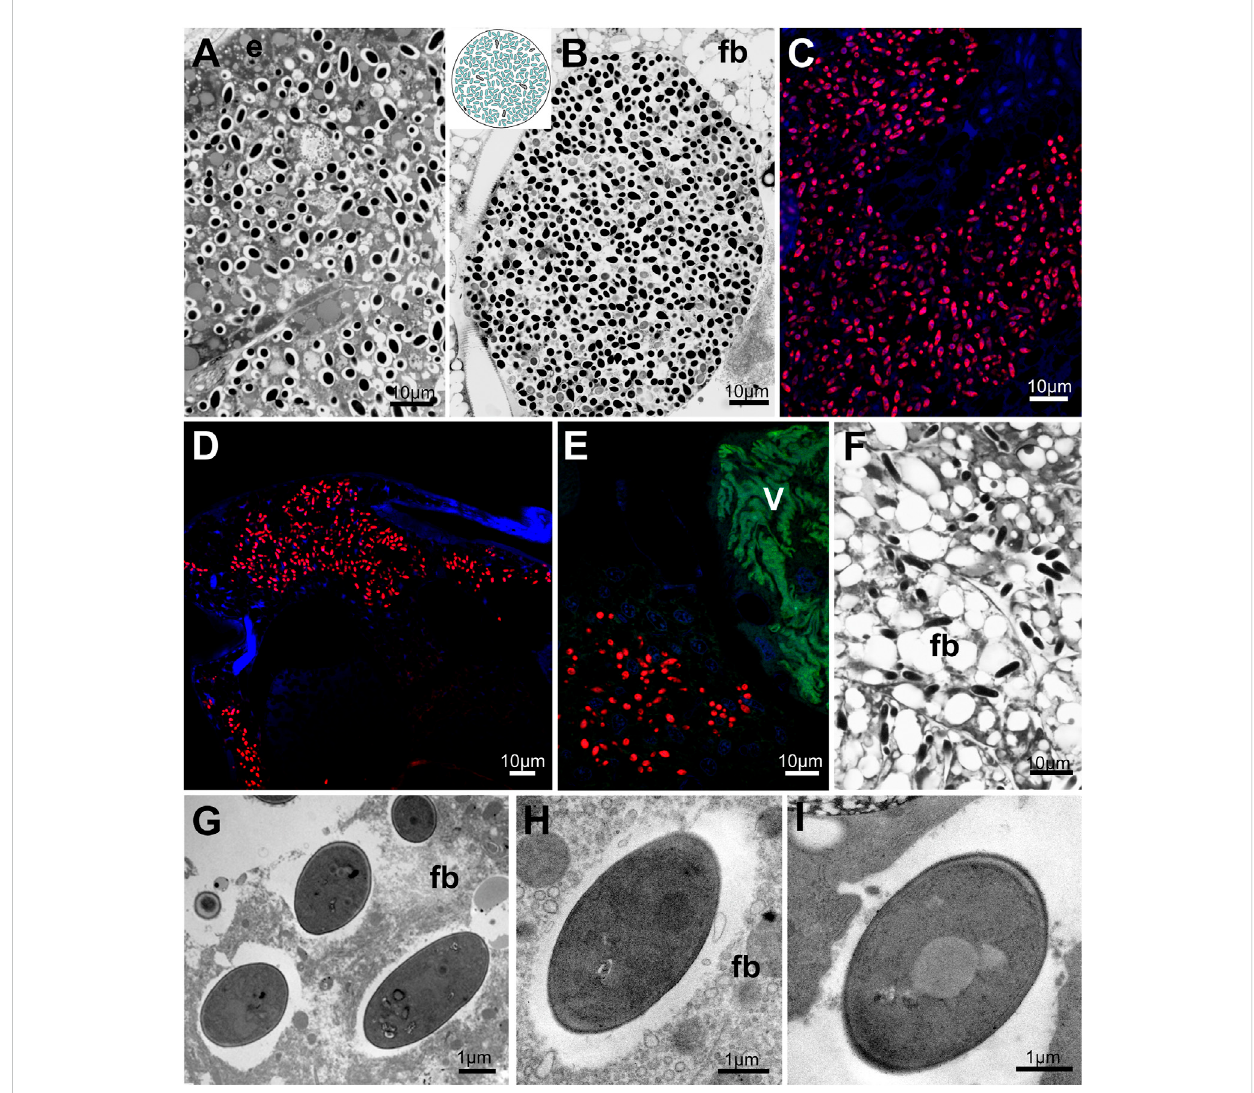
Distribution of fungal symbionts within planthopper tissue. (A,B) Mycetocyte with fungal symbionts. (C) Group of fat body cells occupied by fungal symbionts. (D – F) Fungal symbionts dispersed within fat body cells. (G – I) Ultrastructure of fungal symbiont cells. For a detailed description of these images, see themain text. (A,B,F) Light microscope (LM). (C,D,E) Confocalmicroscope. (G – I) Transmission electron microscope (TEM). (E) epithelium, fb -fatbody,V- Vidania. Insectspecies: (A) . Metcalfapruinosa (Flatidae) (B) Phantiasubquadrata (Flatidae) (C) Chlorionaglauscesens (Delphacidae)